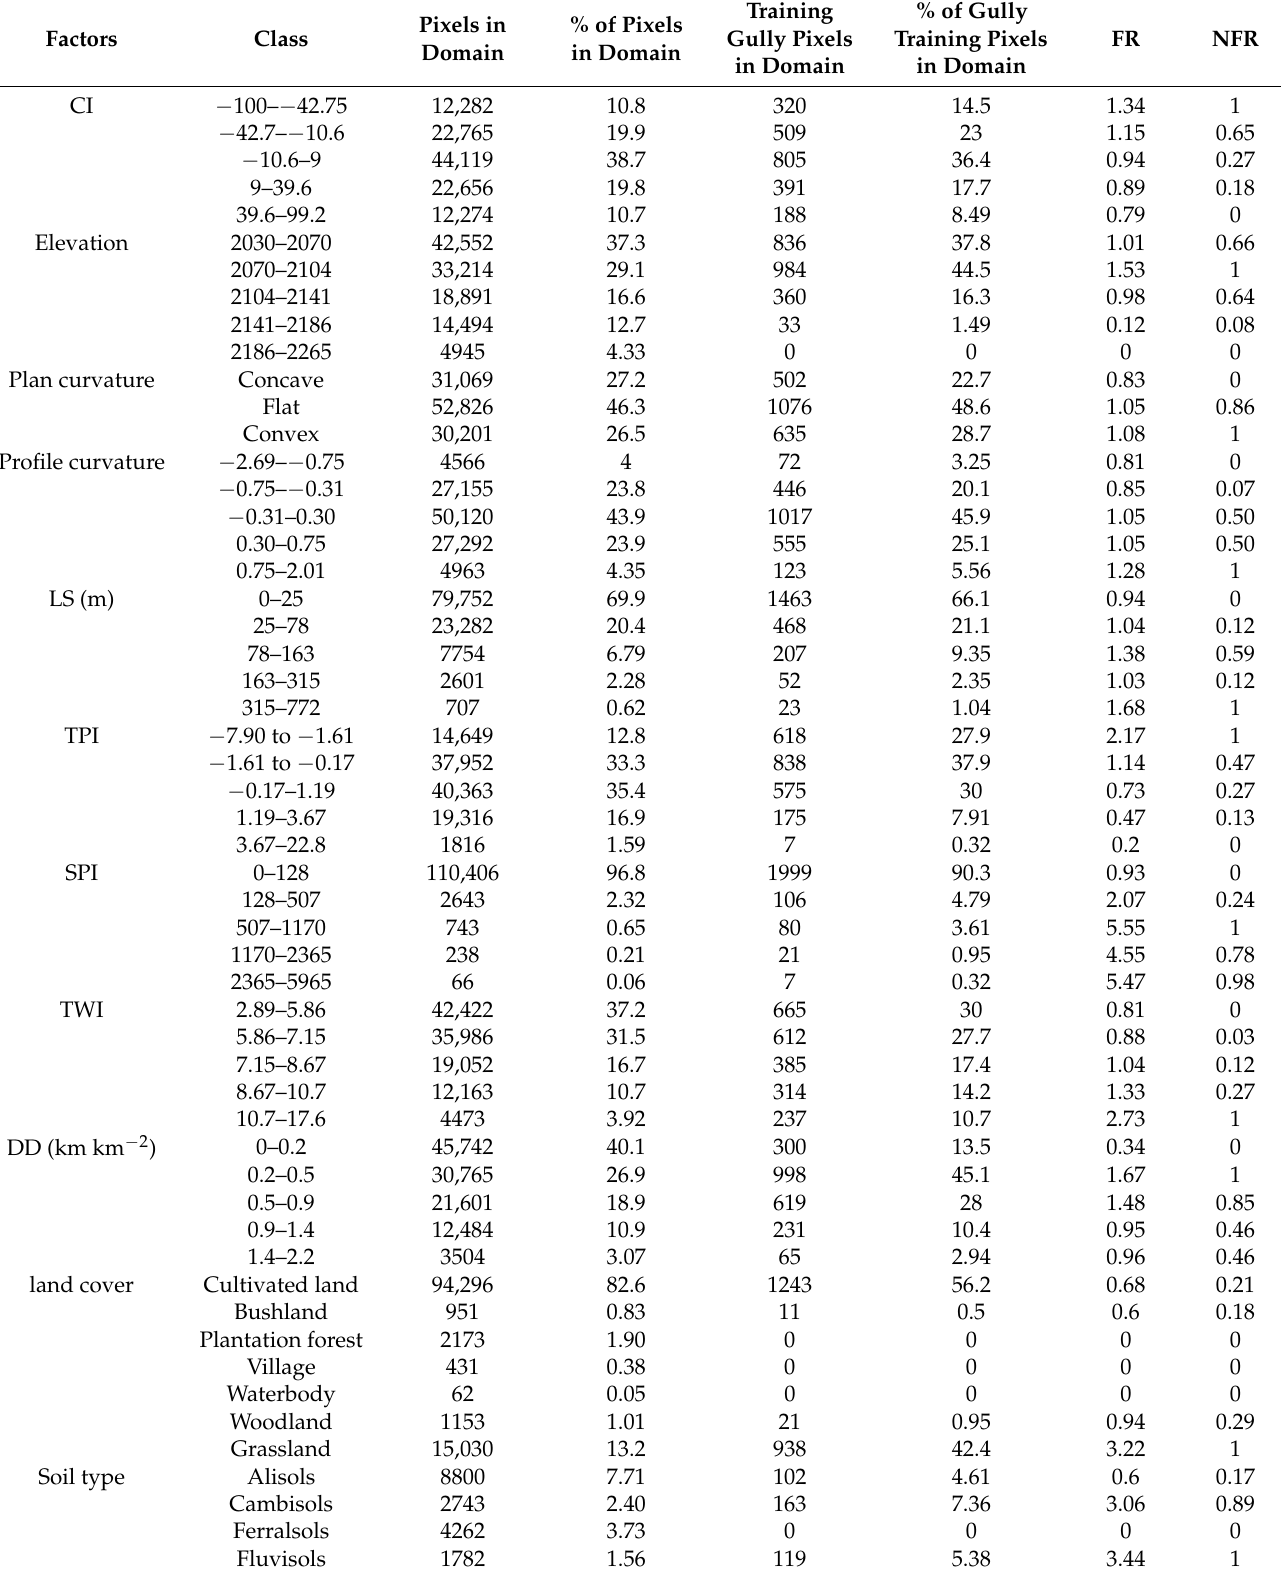
Table 5. (1) Areal coverage of gully predictor factors and training gully pixels and (2) the frequency ratio (FR) and normalized frequency ratio (NFR) calculated for the training data